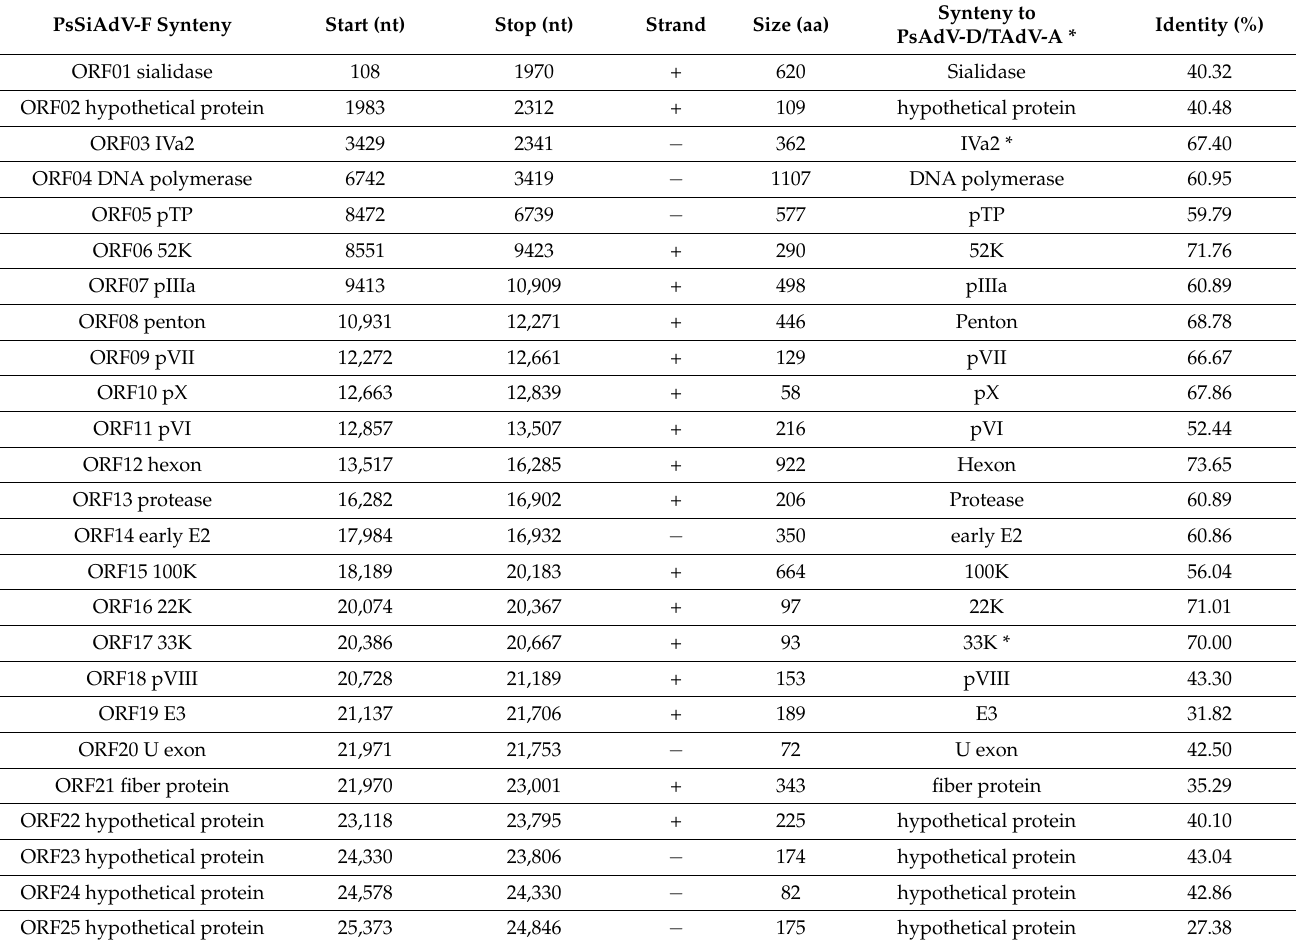
Table 1. Predicted protein-coding genes of PsSiAdV-F.